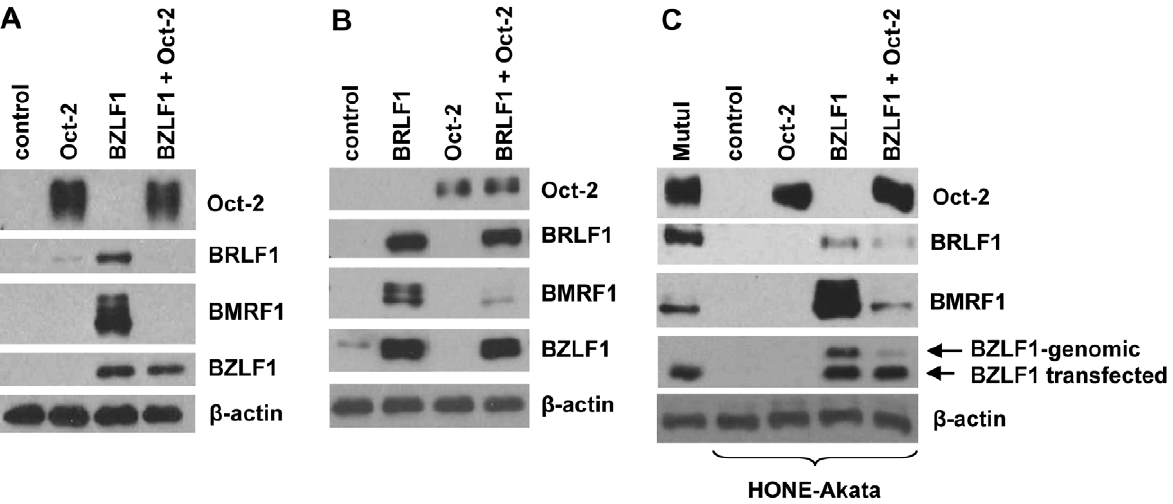
Figure 1. Oct-2 inhibits BZLF1-mediated lytic viral reactivation. (A) EBV-positive HONE-Akata cells were transfected with 5 ng BZLF1, 500 ng Oct-2, or control expression vectors as indicated. Immunoblot analysis was performed two days after transfection to compare the levels of transfected Oct-2 and BZLF1, as well as the lytic viral proteins BMRF1 and BRLF1 derived from the endogenous viral genome. b -actin expression was used as a loading control. (B) HONE-Akata cells were transfected with 5 ng BRLF1, 500 ng Oct-2, or control expression vectors as indicated. Immunoblot analysis was performed two days after transfection to compare the levels of transfected Oct-2 and BRLF1, as well as the lytic viral proteins BMRF1 and BZLF1 derived from the endogenous viral genome. b -actin expression was used as a loading control. (C) HONE-Akata cells were transfected with control vector or 50 ng Oct-2 expression vector (with or without 5 ng BZLF1) as indicated. Immunoblot analysis was performed two days after transfection to compare the levels of transfected and endogenous Oct-2 in HONE-Akata and MutuI cells, the levels of transfected BZLF1, and the lytic viral proteins, BZLF1 (genomic BZLF1), BRLF1, and BMRF1, derived from the endogenous viral genome. b -actin served as a loading control.